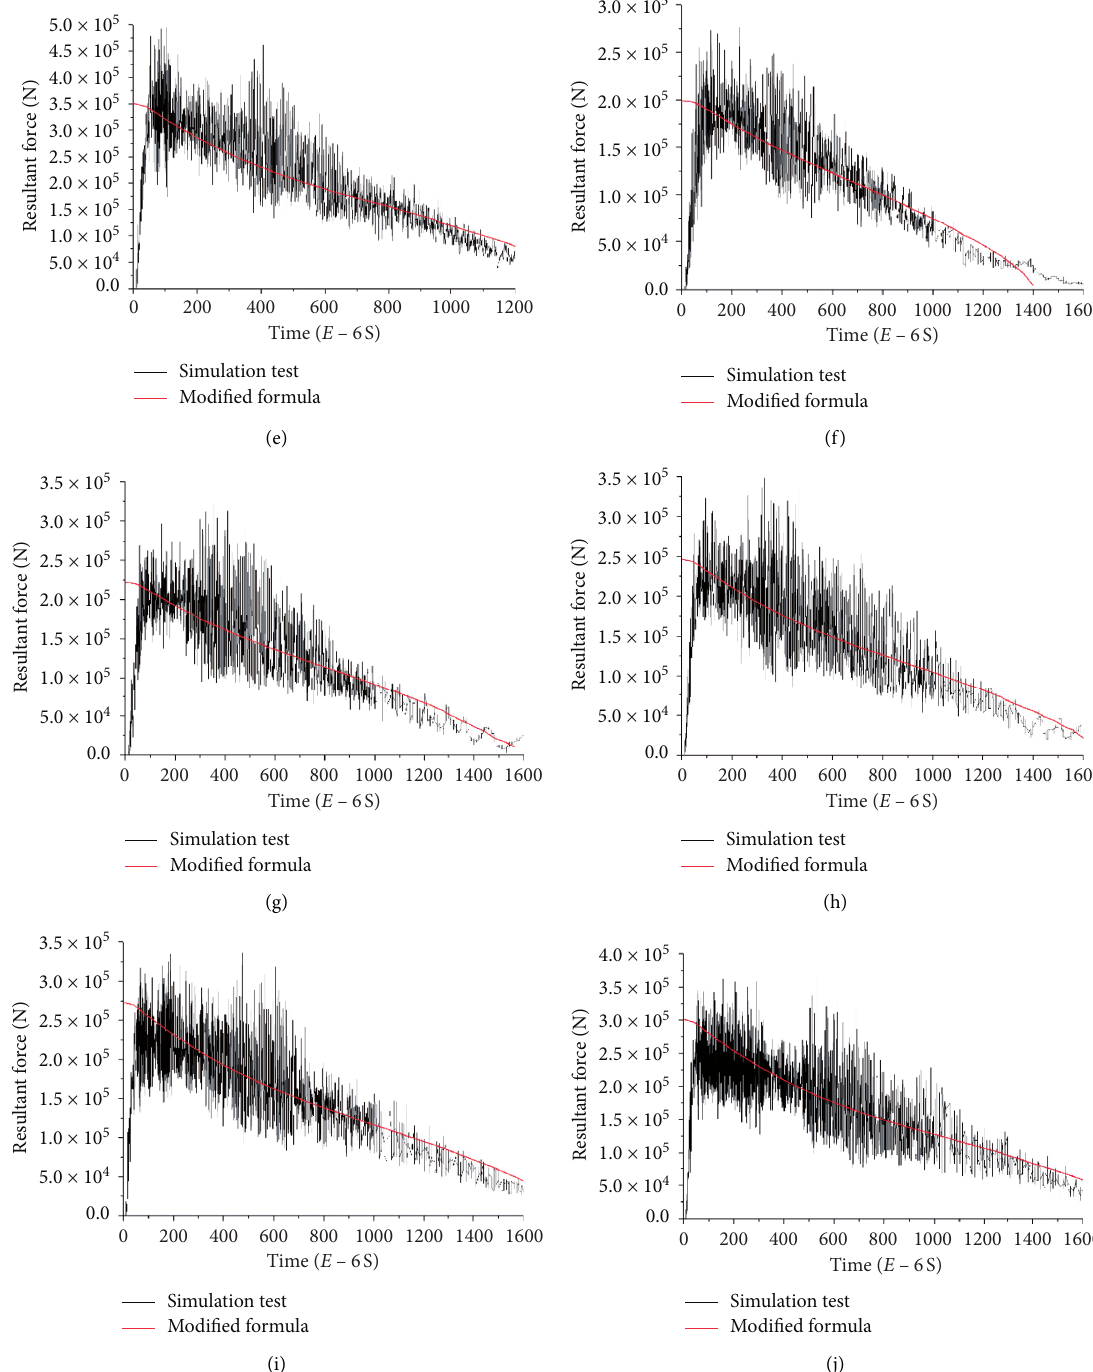
Figure 11: Comparison between simulation and modified formula of concrete penetration. (a) 40MPa. (b) 50 MPa. (c) 60 MPa. (d) 70MPa. (e) 80MPa. (f) 600m/s. (g) 700m/s. (h) 800m/s. (i) 900m/s. (j)